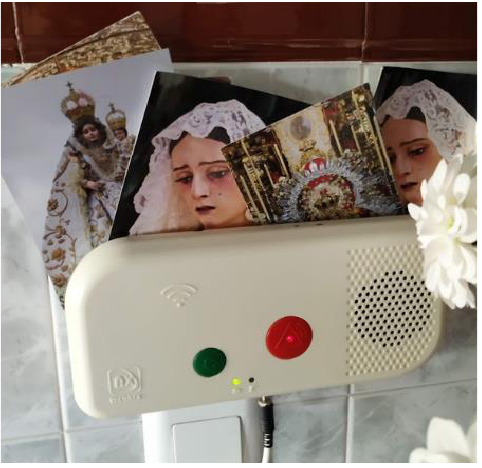
Photograph 15: Photos of Virgin Mary statue tucked behind a fall- alarm in Louisa’s bedroom in the care home. Photograph taken by author. September,